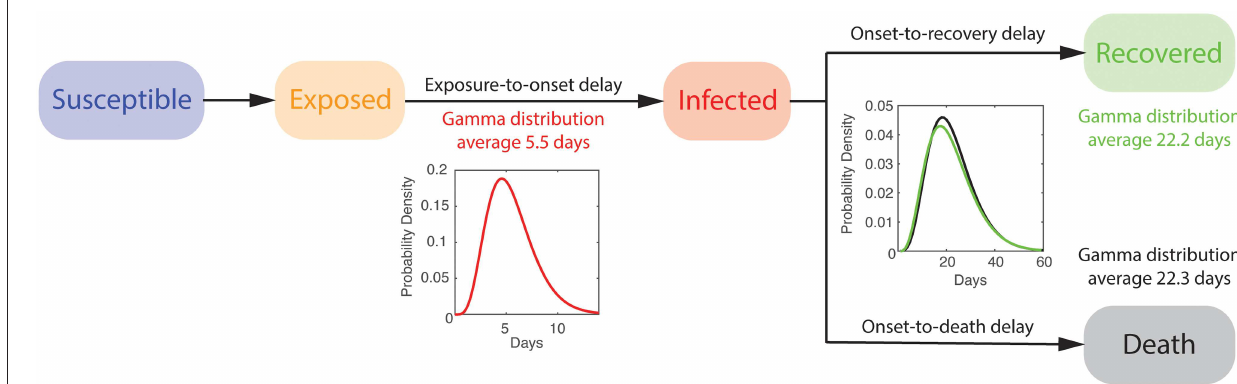
FIGURE 2 | Schematic illustration of the formulated mathematical epidemic